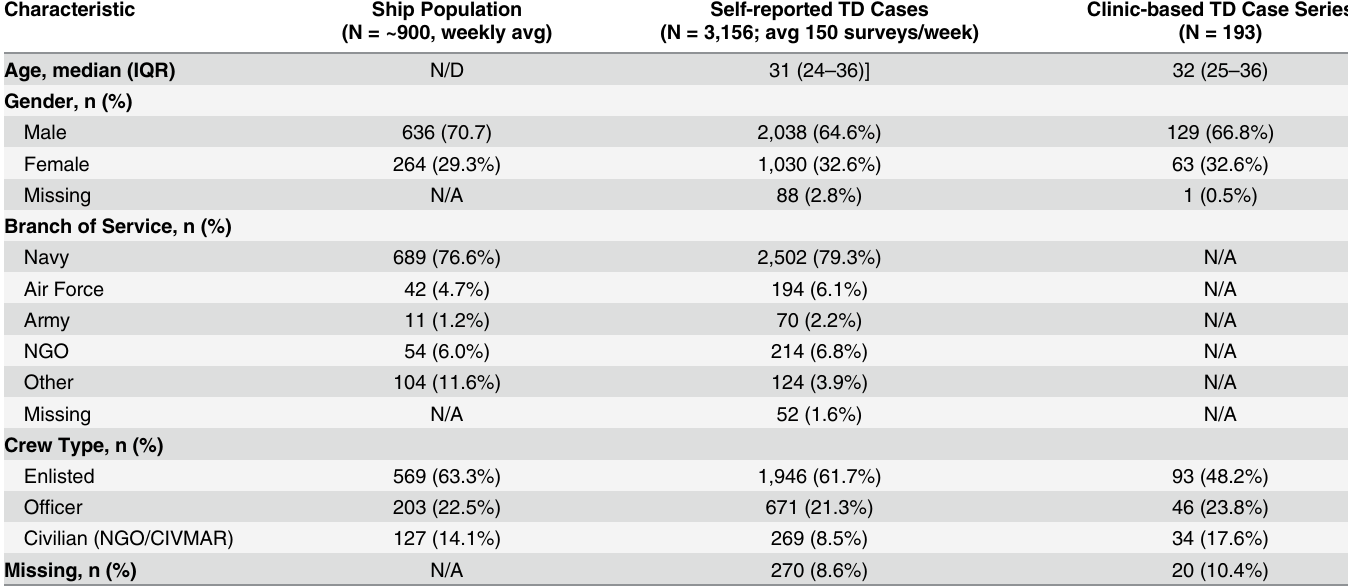
Table 1. Continuing Promise 2011 Population and Sample Demographics.